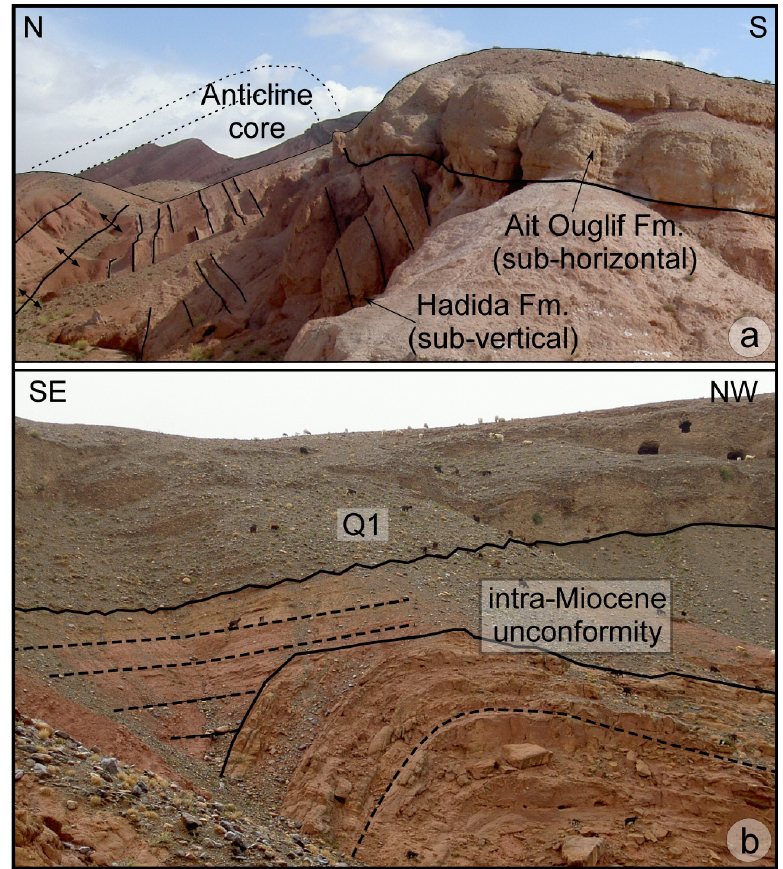
Figure 4. (a) Photograph of a local unconformity between the Hadida and the Ait Ouglif formations in the core of the Amekchoud anticline in the Tabia area, looking from the west. The field of view is ca. 40 m. (b) Minor unconformity within the Miocene red beds of the Ait Kandoula formation in the core of the Amekchoud anticline in the Tabia area. The field of view is ca. 100 m. See Figures 2 and 3 for